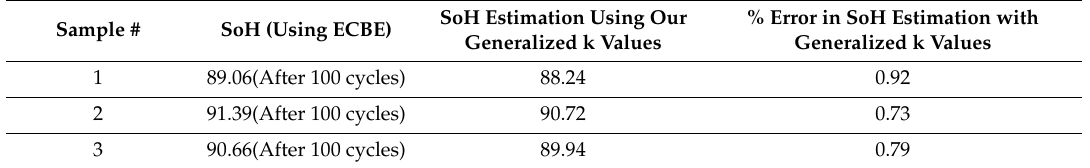
Table 12. Verification of the model for additional three more batteries tested at 55 ◦ C and 5 C discharging